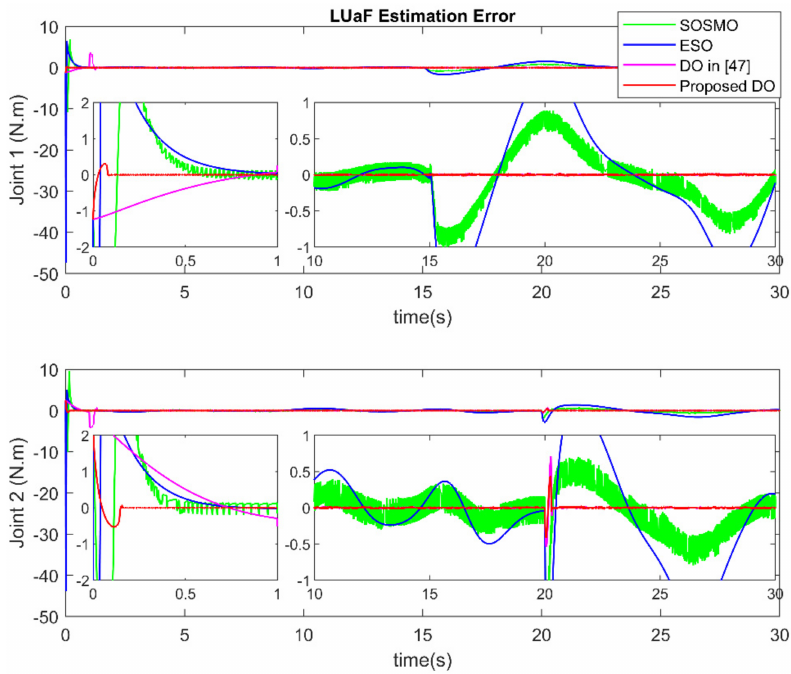
Figure 4. The LUaF estimation error at each